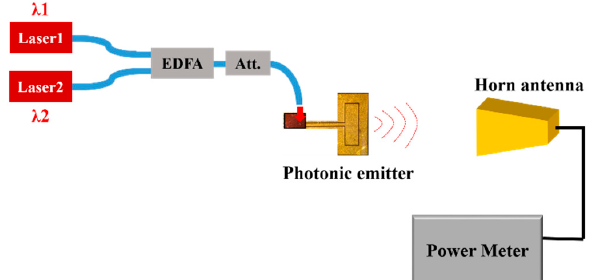
fiber amplifier, Att.: optical attenuator.